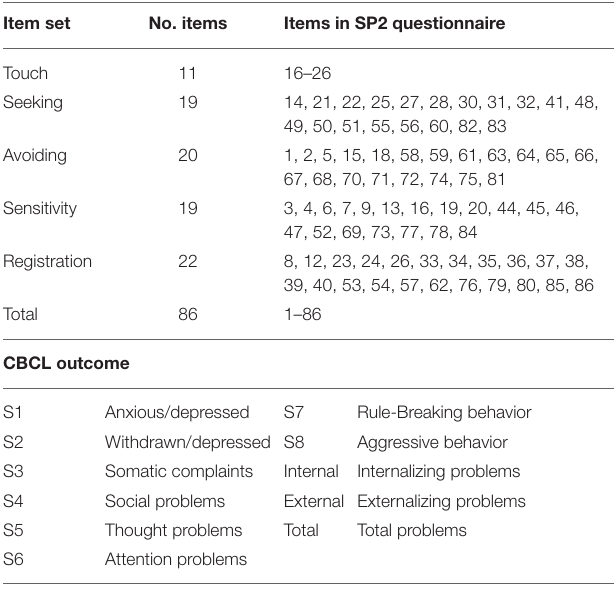
TABLE 1 | List of the six item sets used as inputs by the machine learning regressors (touch, total, and the four quadrants from the SP2 questionnaire), with the number of items and the items included in each